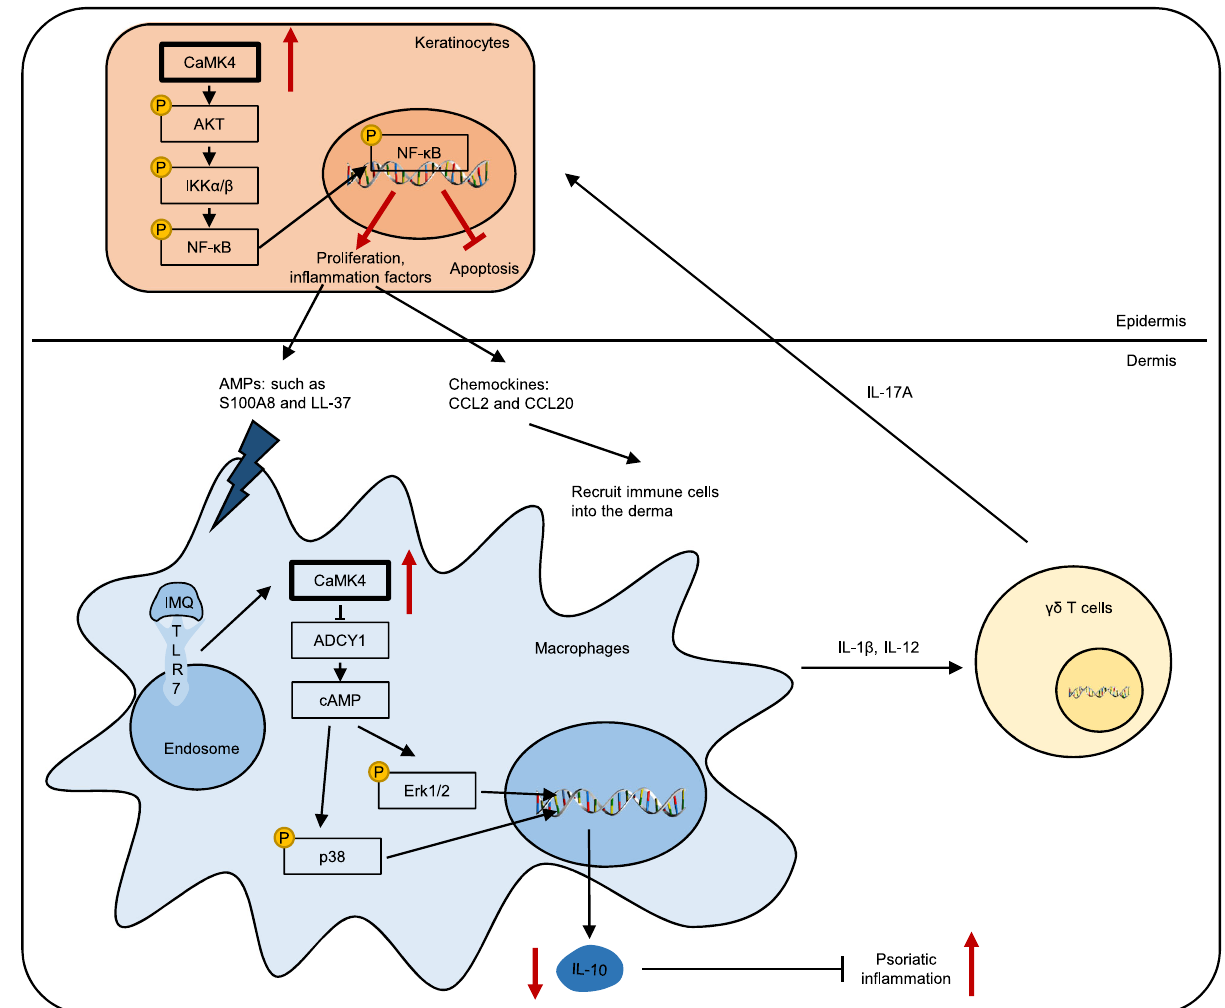
Fig. 10 | Model diagram of the mechanism underlying CaMK4 in the patho- genesis of psoriasis. CaMK4 is increased in IMQ- or AMP-activated macrophages andinhibitsIL-10productionthroughtheADCY1-cAMP-Erk1/2andp38pathwaysas well as reduces the level of IL-10 in the skin, thus allowing excessive psoriatic in fl ammation. CaMK4 also upregulates monocyte-derived IL-1 β and IL-12